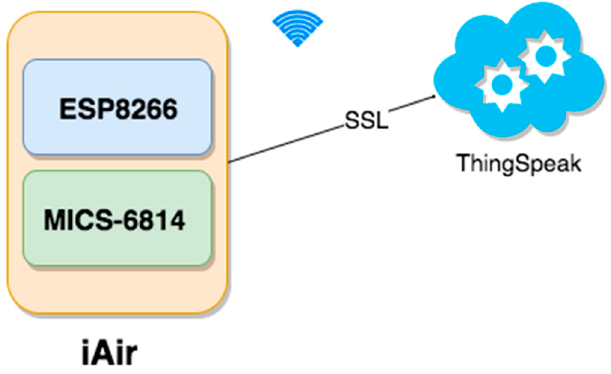
Figure 3. iAir and ThingSpeak platform communication.